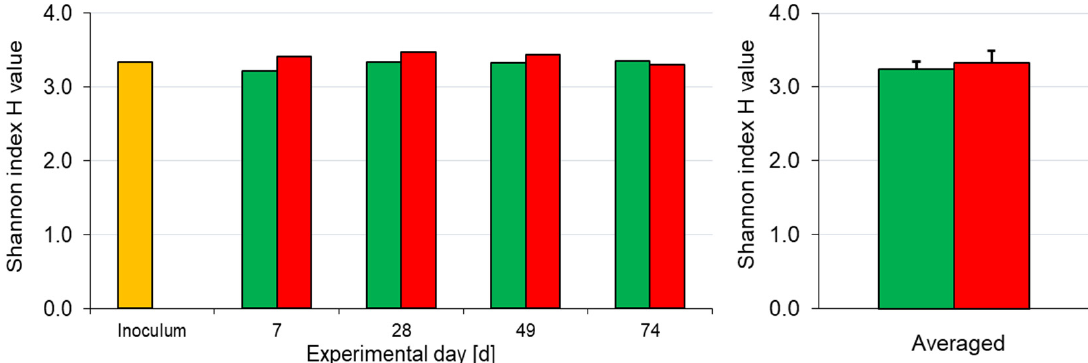
Figure 5. Shannon index H values representing biodiversity of the activated sludge samples during the experimental period: ■ Inoculum; ■ reference reactor (REF) ■ reactor with fusel oil addition (FO).